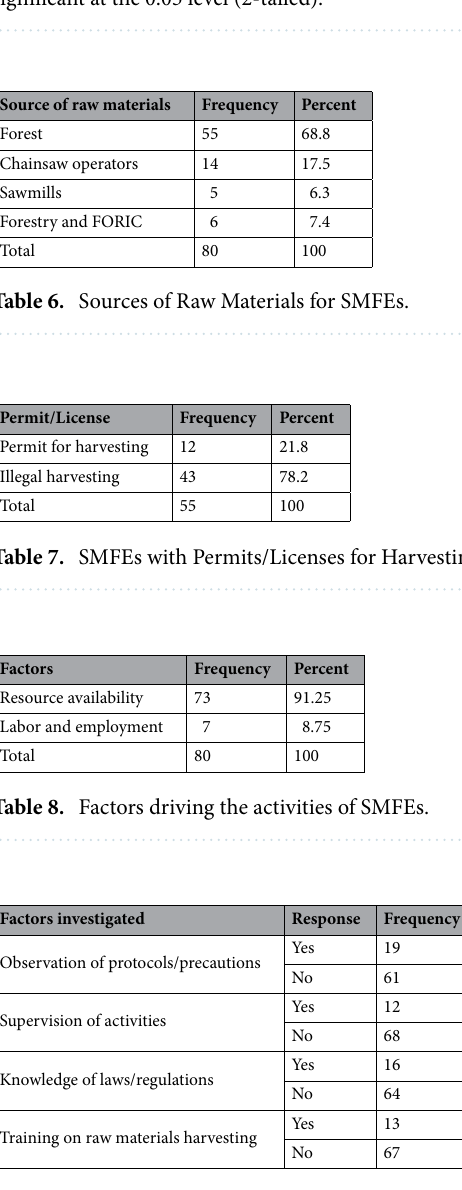
Table 9. Factors Undermining Sustainable Forest Management concerning